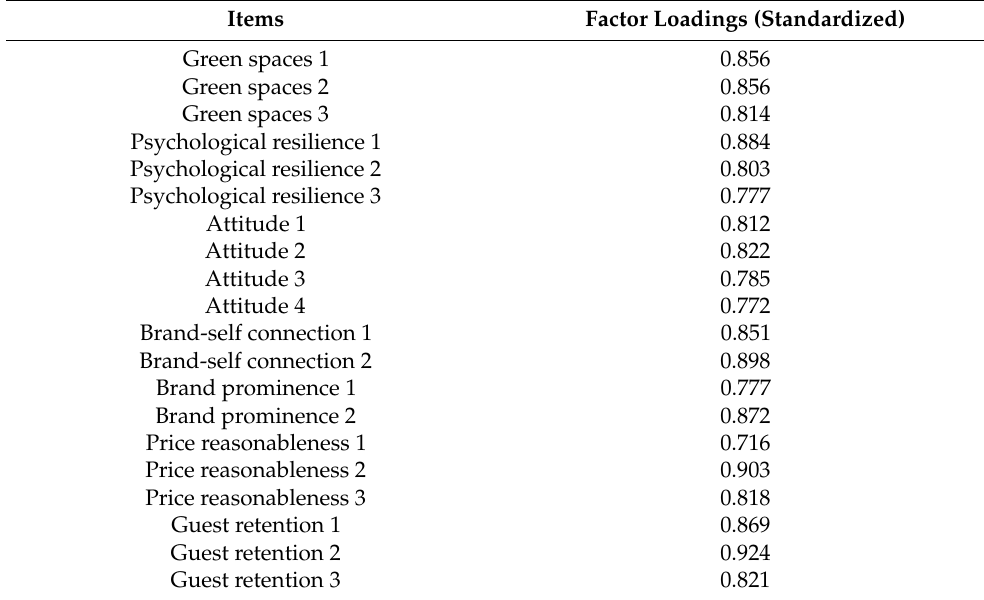
Table 1. Measurement items and factor loadings (n = 403).